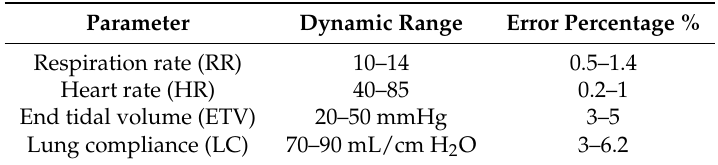
Table 3. Physiological parameters that can be inferring from computer-generated imagery (CGI) neonatal imaging